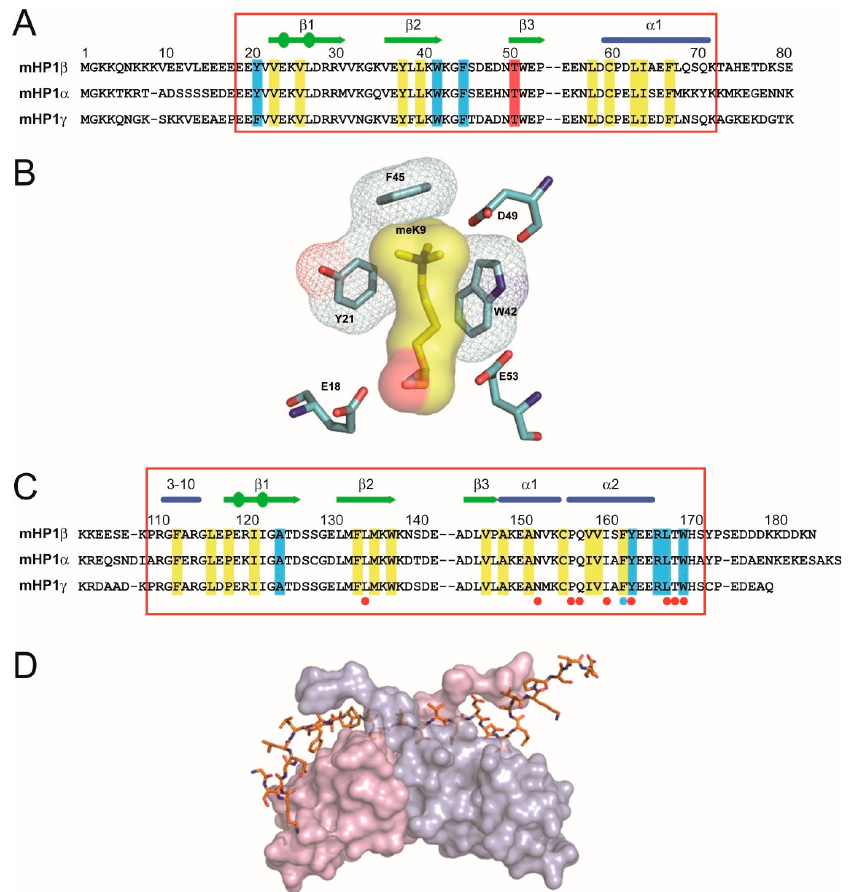
Figure 1. Alignment of peptide sequences of the murine HP1 CDs ( A ) and the CSDs ( C ), structure of the aromatic “cage” formed around the K9me3 moiety ( B ) and the CSD dimer bound to PxVxL motif in CAF-1 peptide ( D ). ( A ) The CDs from top to bottom are HP1 β (amino-acids 1–80), HP1 α (amino-acids 1–80) and HP1 γ (amino-acids 1–80). The red box denotes the structured part of the CD. The secondary structure elements of the HP1 β CD are displayed above the sequence: blue cylinders represent a α -helix ( α 1) and green arrows represent β -strands; circles within the arrows indicate β -bulges. The residues that make up the hydrophobic core of the CD are shaded in yellow and the aromatic residues that form a notional “cage” around the methyl lysine are given in blue. The Thr51 residue that is phosphorylated after DNA damage [39] is shaded in red. ( B ) Binding of the HP1 β CD to H3K9me3 a notional aromatic ‘cage’ is formed from three conserved aromatic residues: Tyr21, Trp42 and Phe45. The interaction between the methyl-ammonium moiety and the aromatic cage is largely electrostatic where the positively charged (cation) moiety is attracted to the negative electrostatic potential of the aromatic groups’ π -system [36]. ( C ) The CSDs from top to bottom are HP1 β (amino-acids 103–185), HP1 α (amino-acids 106–191) and HP1 γ (amino-acids 97–173). The red box denotes the structured part of the CSD. The secondary structure elements of the HP1 β CSD are given above the sequence, where the cylinders represent the α -helices ( α 1 and α 2) and the arrows represent β -strands; circles within the arrows indicate β -bulges. The residues that make up the hydrophobic core of the CSD are shaded in yellow and show good alignment with those found in the CD indicating a similar overall structure of the CSD to the CD. Residues that are involved in binding the PxVxL motif are shaded in blue; there is a blue dot below the Phe163 residue, which is involved both in the structure of the CSD and in binding to the peptide. There are red dots below the residues that are involved in CSD:CSD dimerisation. ( D ) Surface view of the CSD homodimer (one monomer in pink and the other in blue) bound to the CAF-1 peptide (shown as a stick model) containing the PxVxL motif, which is involved in intermolecular β pairing with both monomers [37]. Taken and modified from